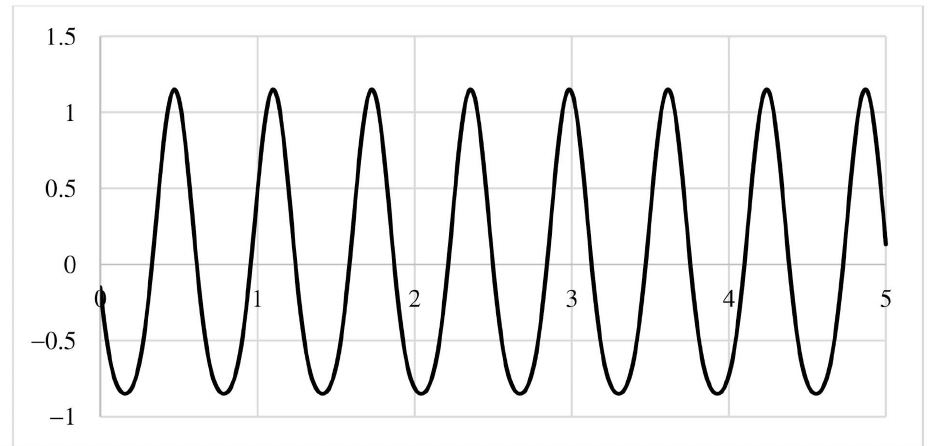
Figure 3. Output current ( i 2 ) waveform of the class-E amplifier.